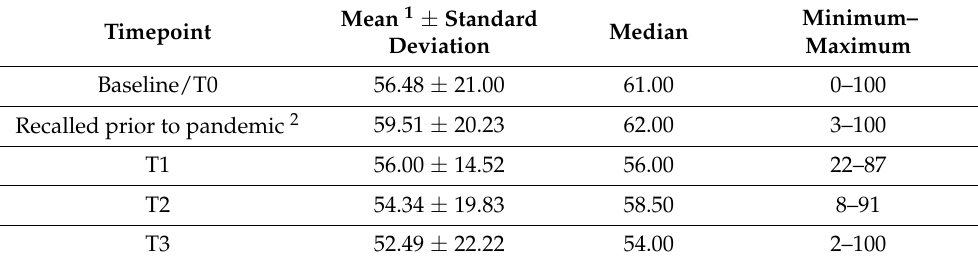
Table 5. Descriptive statistics for headache intensity by